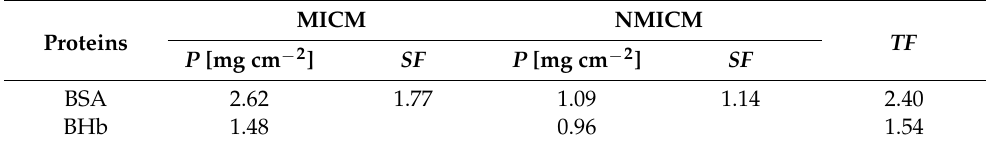
Table 6. The permselectivity of MICM and NMICM in mixture solution of BSA and BHb.